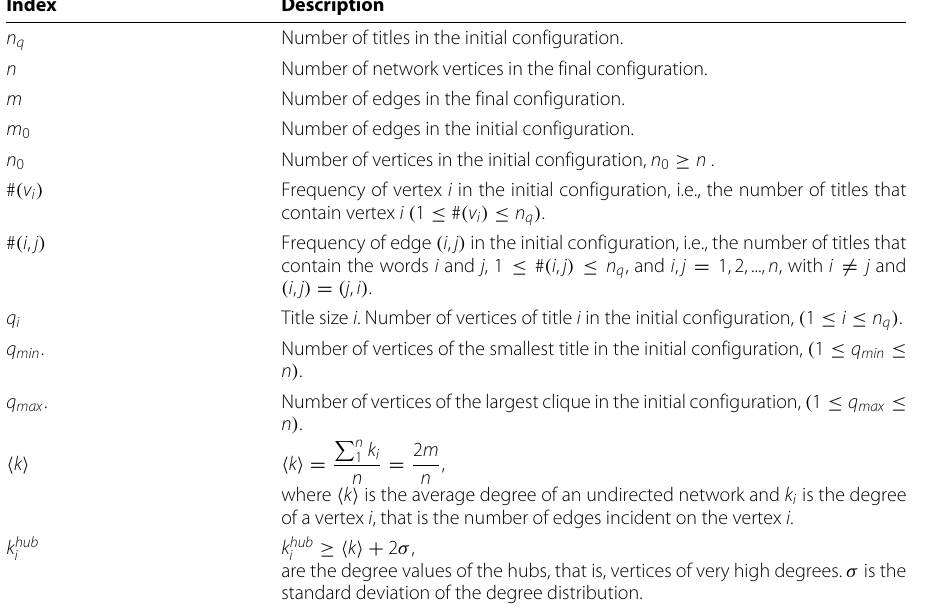
Table 1 Main indices of clique network used in this paper Index Description n q Number of titles in the initial configuration. Number of network vertices in the final configuration. Number of edges in the final